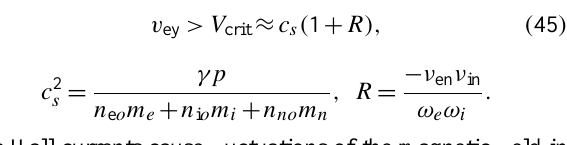
Fig. 2. Three solutions of the dispersion relation of Farley- Buneman waves. The wave frequencies equal ω j = ω ∗ describes the growth rates, V ey o – the amplitude of the electron Hall velocity exciting the waves, and k is the wave number. j = { 1 , 2 , 3 } (Meister,